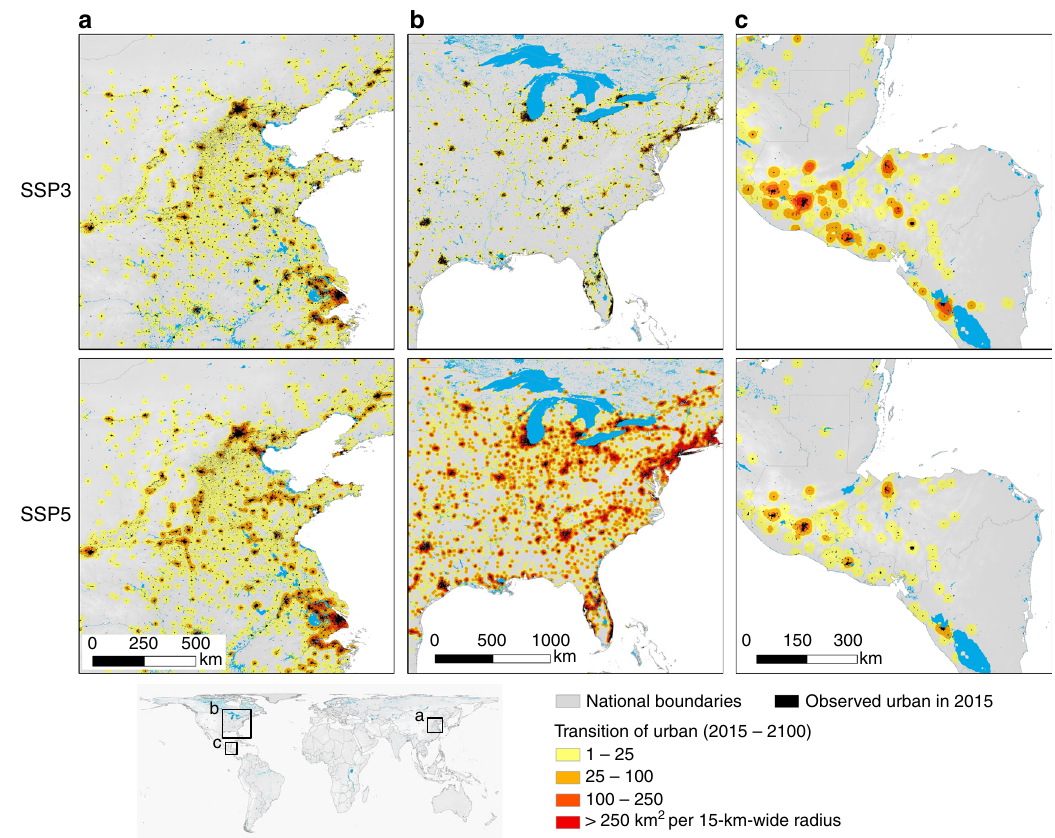
Fig. 2 The simulated urban land maps in 2100 for representative regions in scenarios SSP3 and SSP5. a China, b the USA and c LAM-L. Focal statistics have been applied to the simulated maps for better visualisation. The results show that China and the USA experience more urban land expansion in scenario SSP5 than in SSP3. In contrast, the LAM-L region experiences greater urban land expansion in scenario SSP3 than in SSP5. SSP1